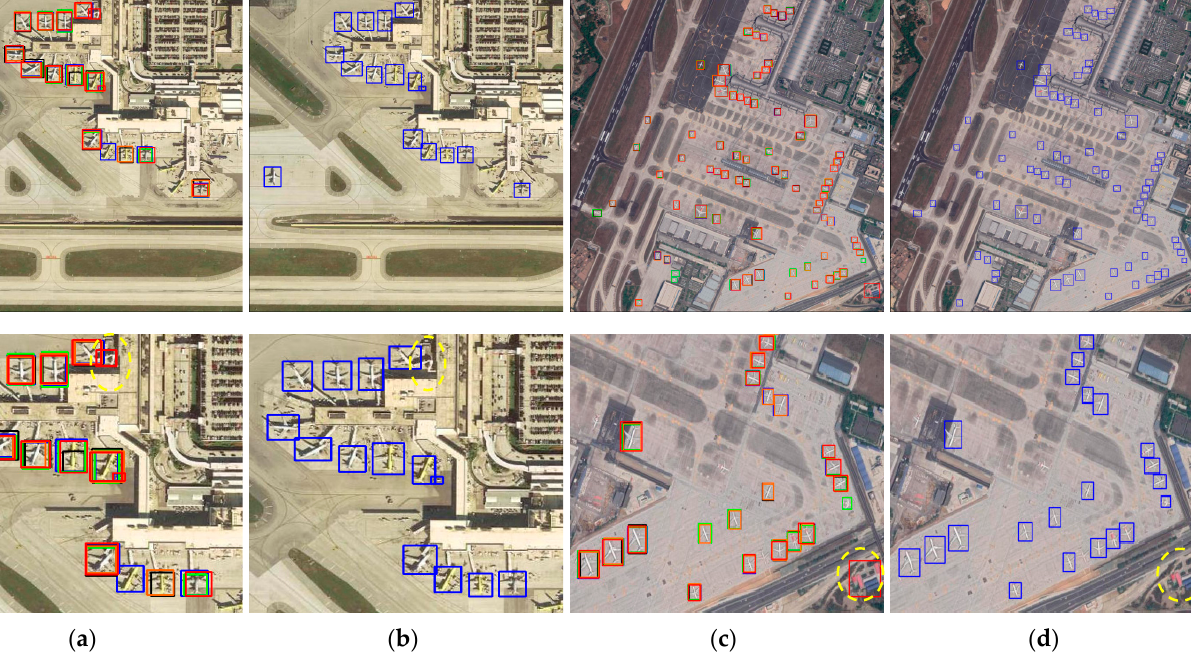
Figure 10. Results after majority voting strategy (The second line are partial enlarge views and the yellow dashed ellipse is used to emphasize the changed area). ( a , c ) Results after multi-angle features driven strategy (different color boxes represent the preliminary detection results). ( b , d ) Results after majority voting strategy. ( a , b ) Dataset II. ( c , d ) Dataset III.